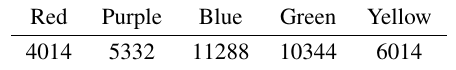
Table 1. Number of voxels in each object